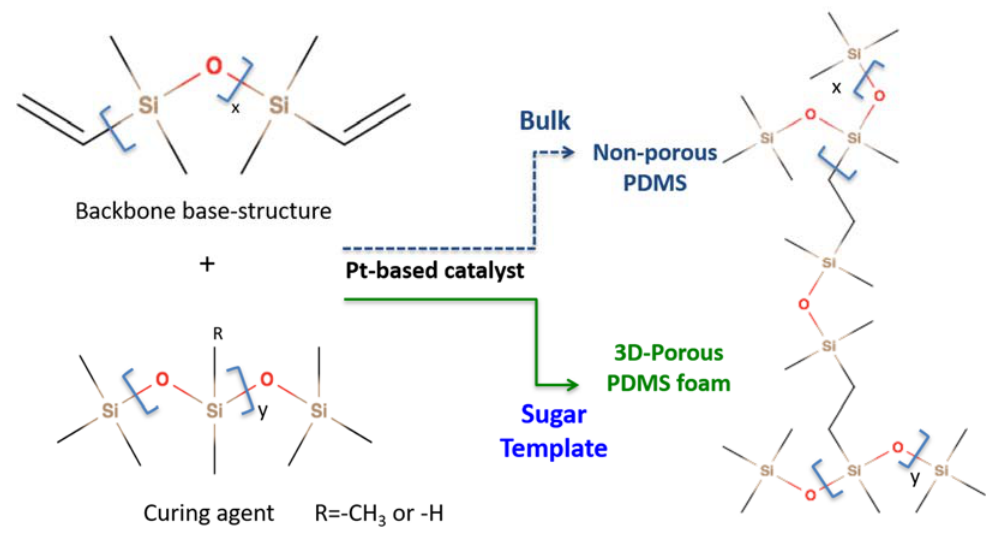
Scheme 1. The PDMS crosslinking polymerization